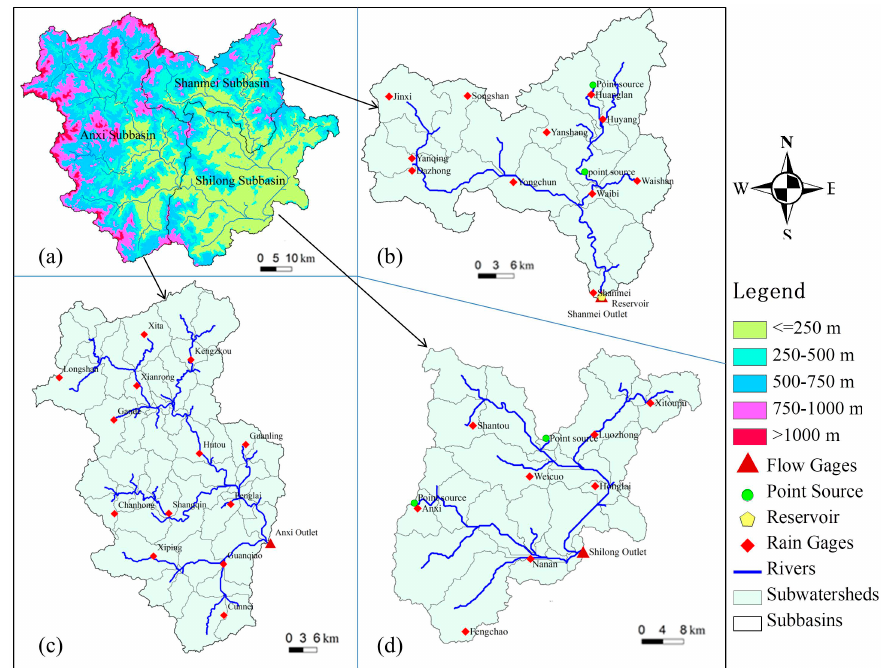
Figure 1. Topography and grain system of Jinjiang watershed ( a ) and its three sub-watersheds: the Shanmei ( b ), Anxi ( c ), and Shilong ( d ) Watersheds.